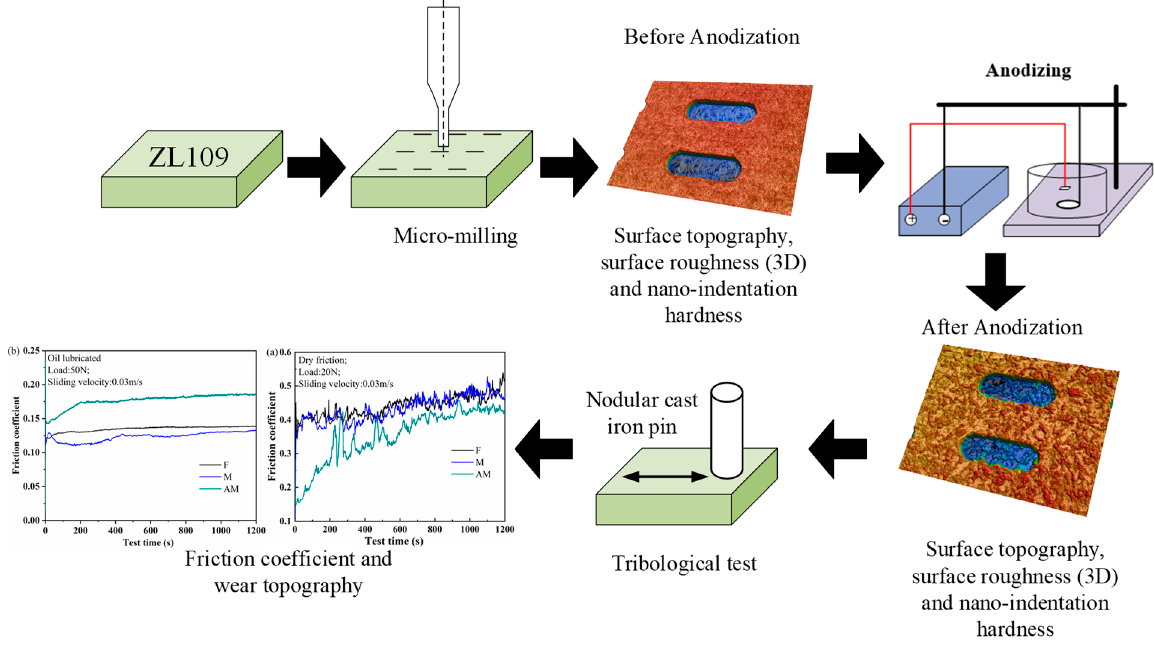
Figure 1. Framework structure of this study.